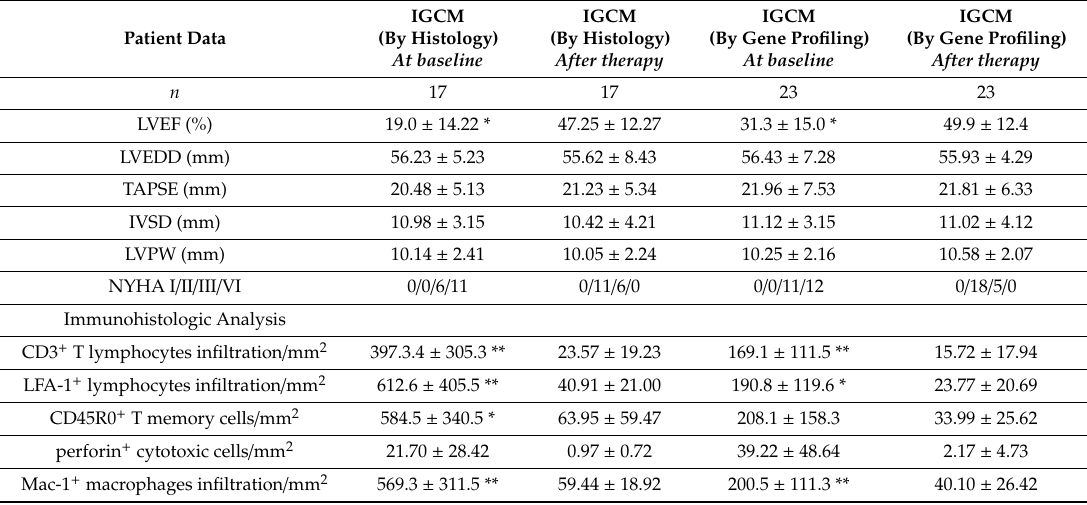
Table 4. Clinical, Hemodynamic, and Immunohistologic EMB-analysis of Intramyocardial Infiltration in GCM patients ( n = 40) Based on Conventional histology and on Gene Profiling at Baseline and After Immunosuppressive